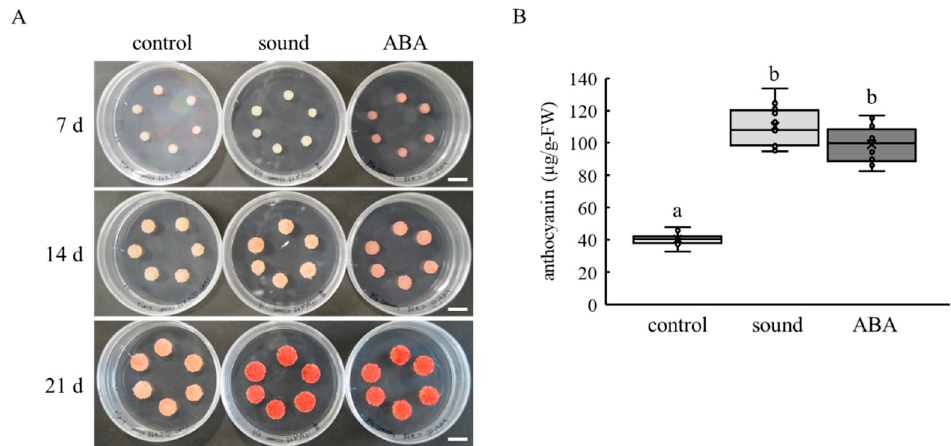
Figure 1. Effect of sound stimulation on anthocyanin accumulation in VR cells. ( A ) Photographs of VR cells. VR cells exposed to sine wave sound at 1000 Hz for 8 h were incubated for 7, 14, and 21 d after treatment. Scale bar: 1 cm. ( B ) Anthocyanin content in VR cells. Measurement of anthocyanin content was performed 21 d after treatment. Data indicate means ± standard errors. Crosses ( × ) indicate means of two independent experiments with six VR cell masses. Different letters (a, b) above the boxes indicate statistically significant differences ( p < 0.01, Tukey). Control, no treatment. Sound, sound stimulation at 1000 Hz. ABA, 1 mM ABA treatment.